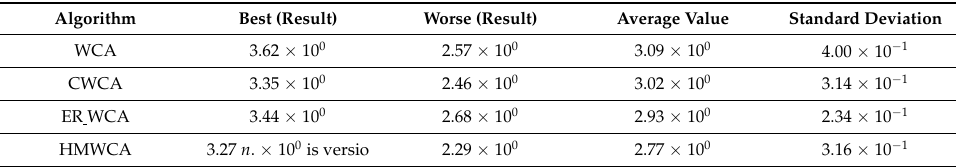
Table 7. Numerical results of the HMWCA on the